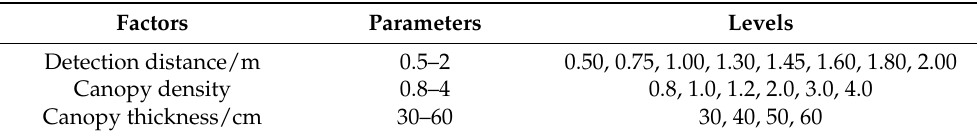
Table 1. Factors and levels.